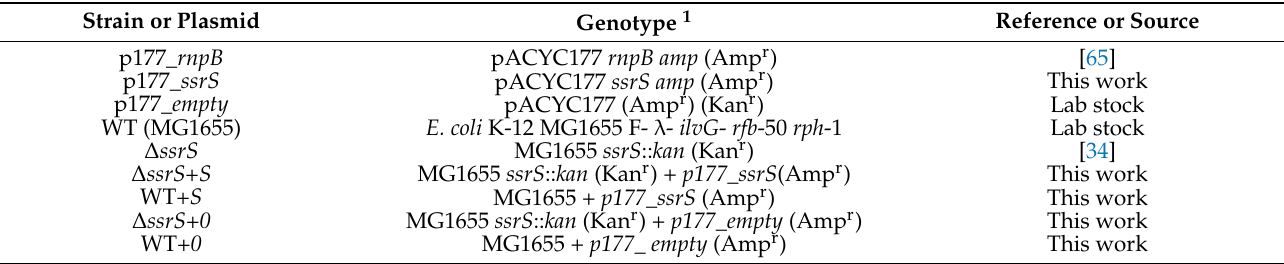
Table 2. Strains and plasmids used in this